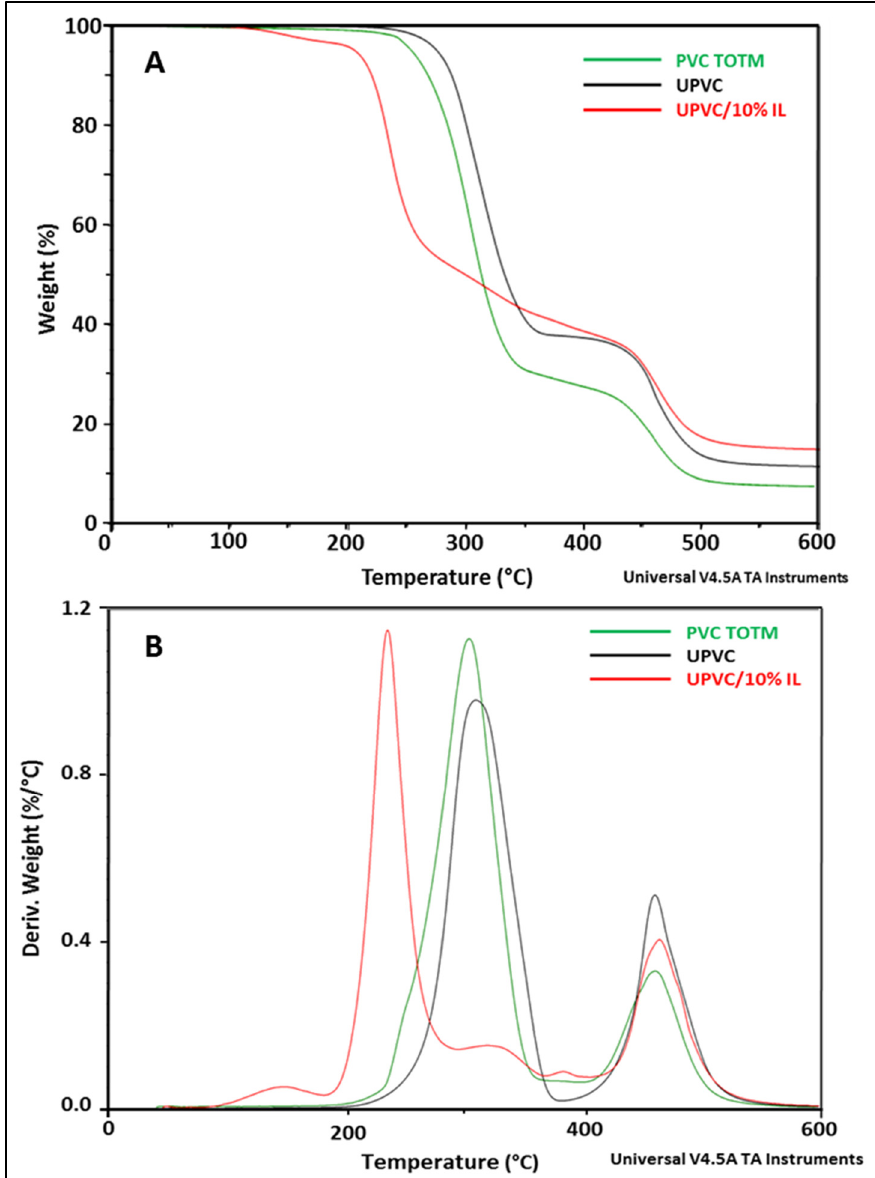
Figure 7. Overlay of TGA ( A ) and DTG ( B ) curves of unplasticized PVC (UPVC), PVC plasticized with TOTM, and UPVC blend containing 10% HdmimDMSIP.